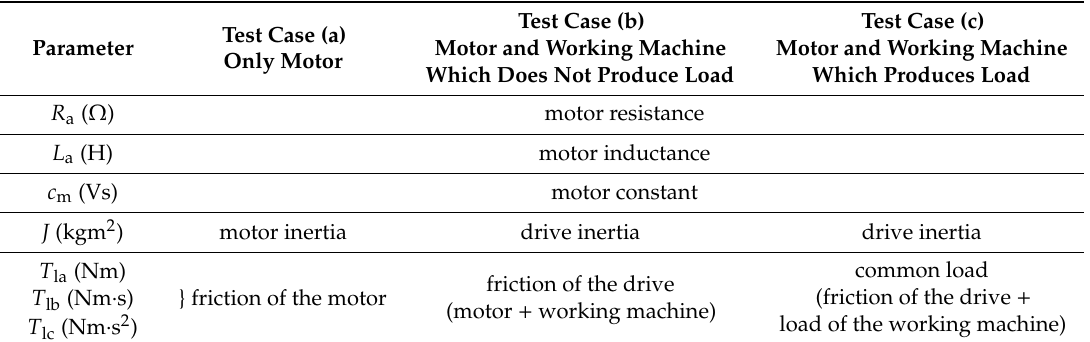
Table 1. Meaning of the searched parameters dependent on the test